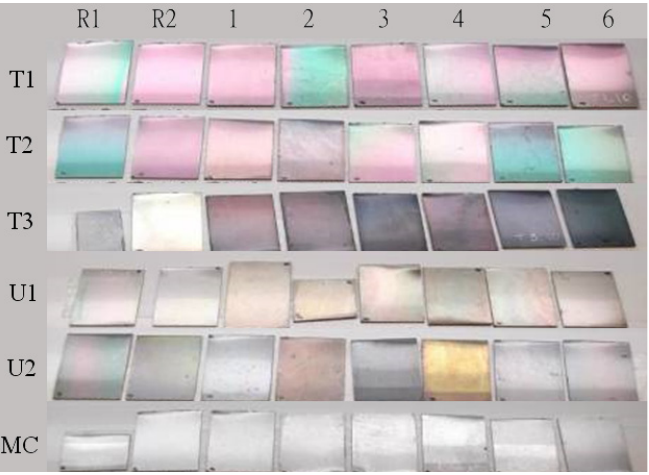
Figure 6. Images of coupons after the three month brewery trial. See Table 2 for sample